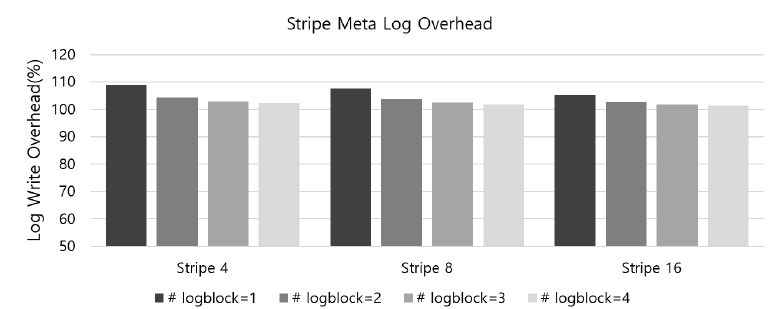
Figure 12. The results of metadata log overhead for the metadata log system for RAID5 architecture with stripe size four, eight, and 16,